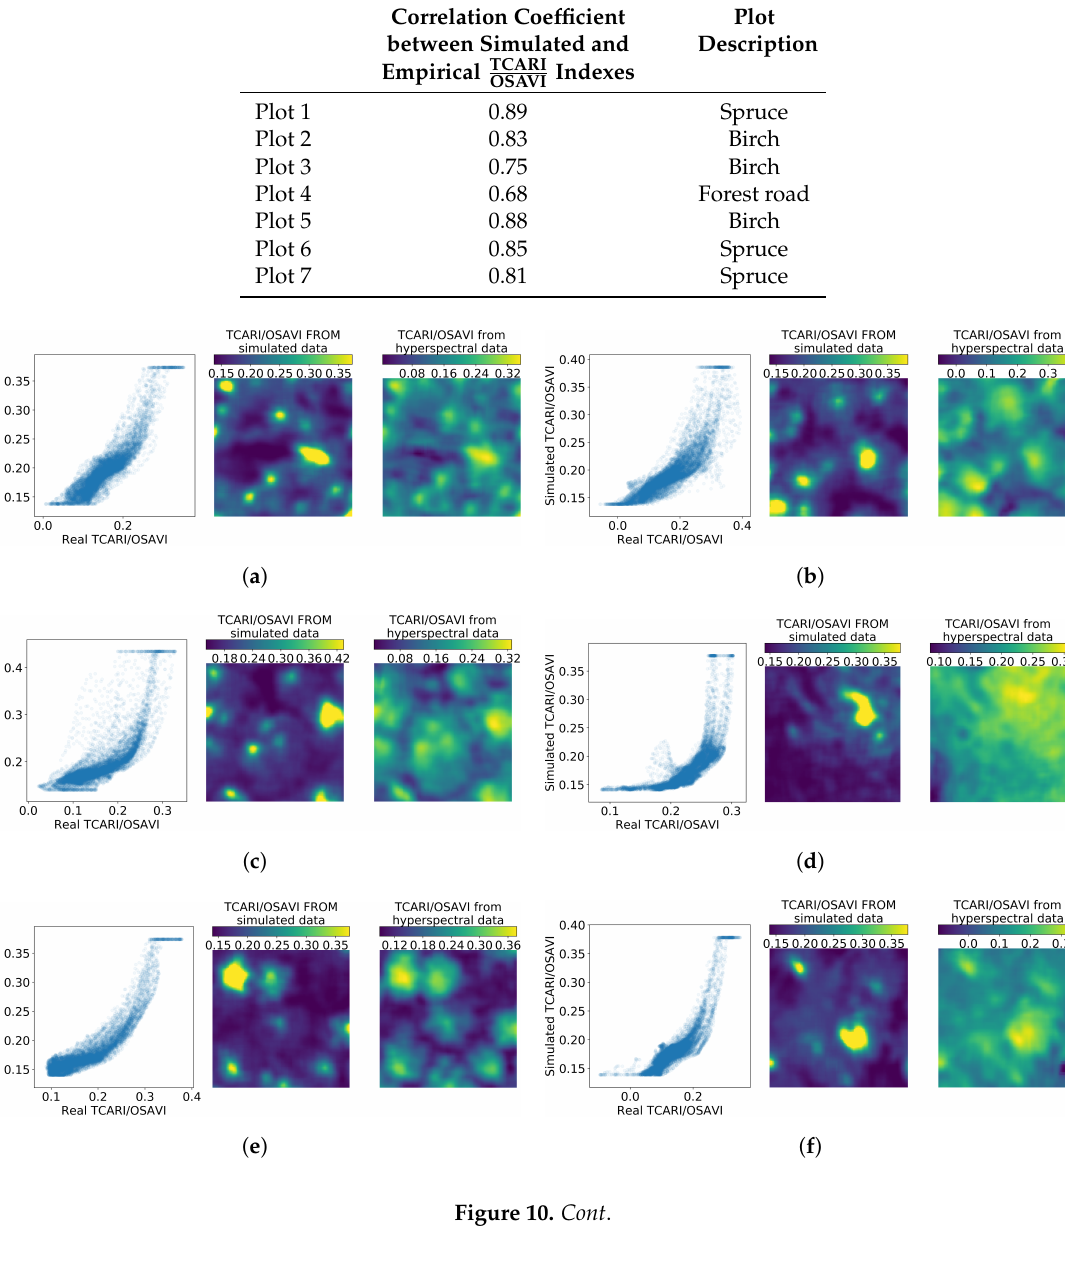
Table 6. Correlation coefficients between simulated and empirical TCARI investigated plots.